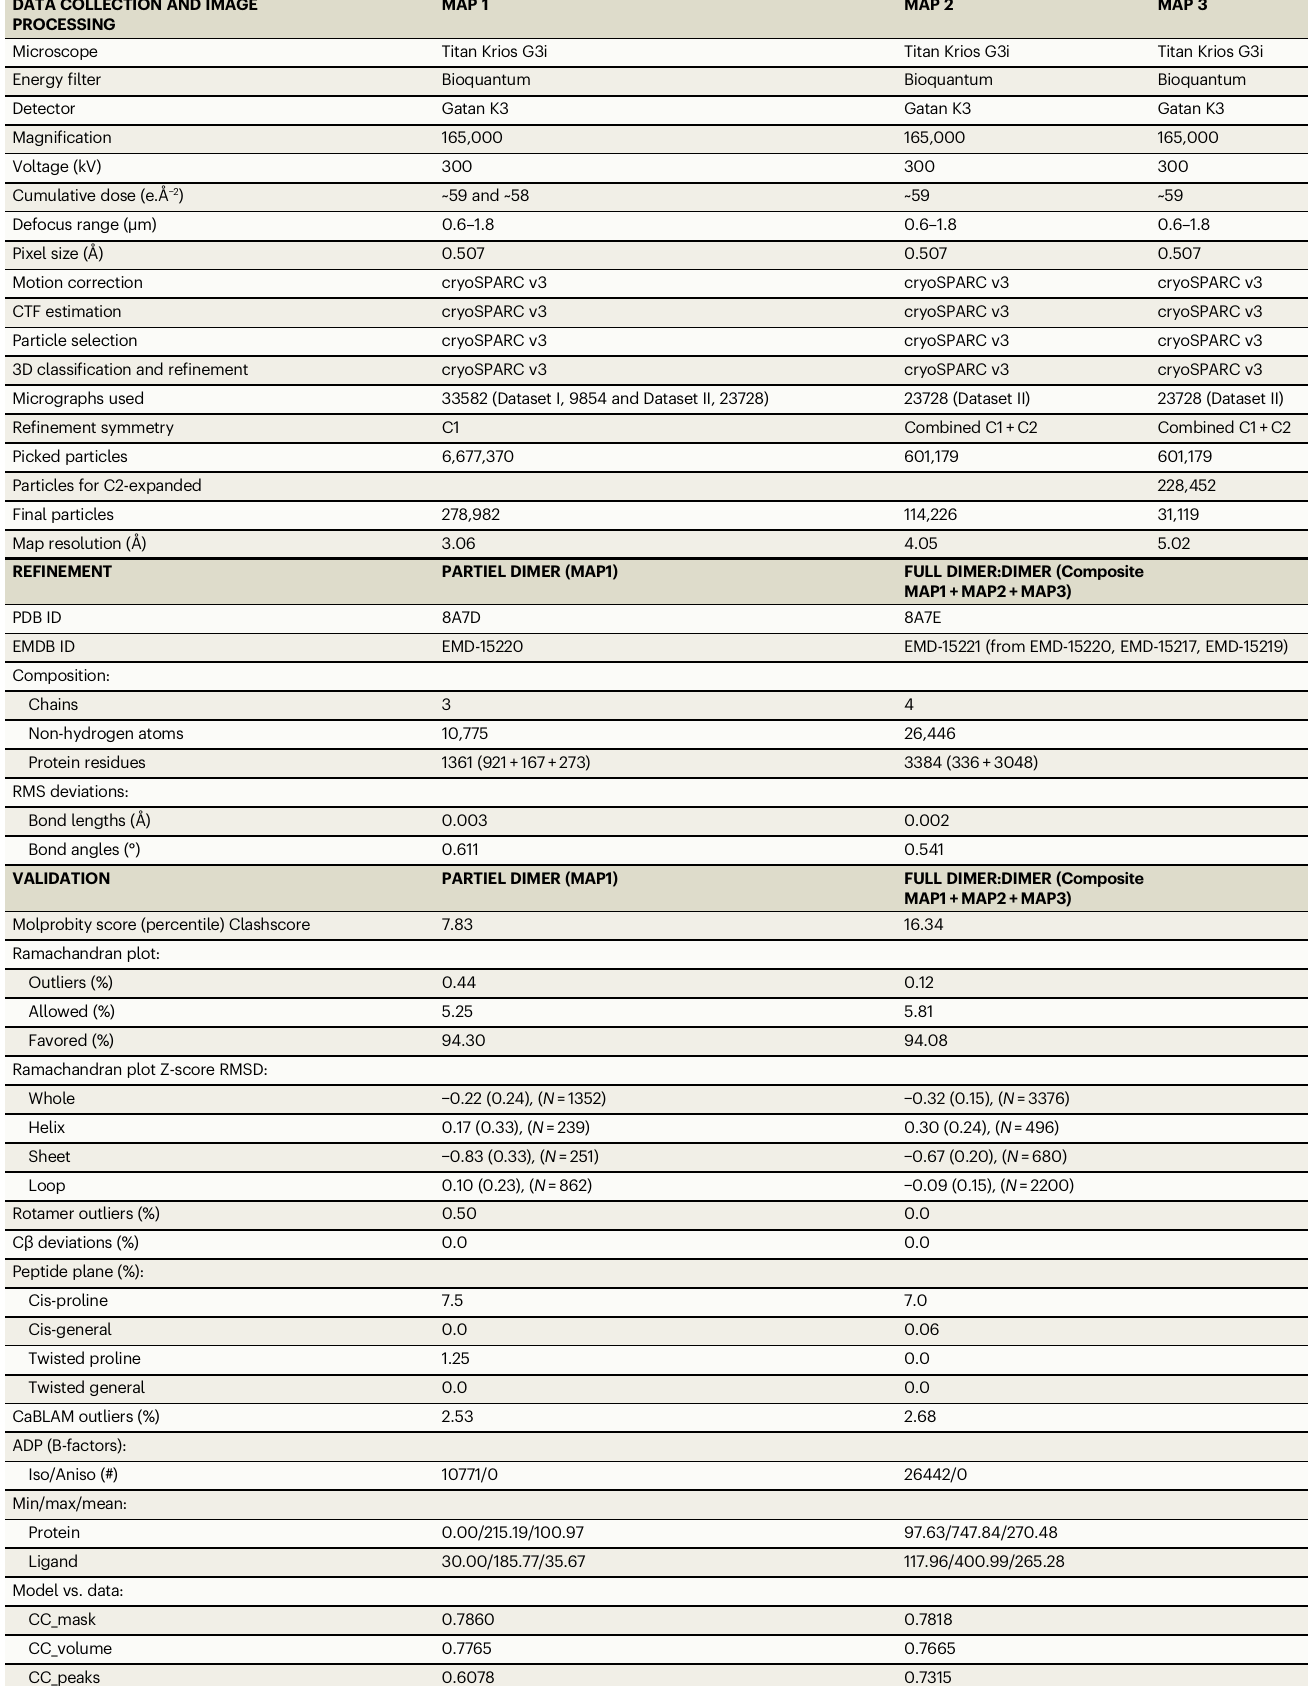
Table 1 | CryoEM data collection, re fi nement, and validation statistics DATA COLLECTION AND IMAGE